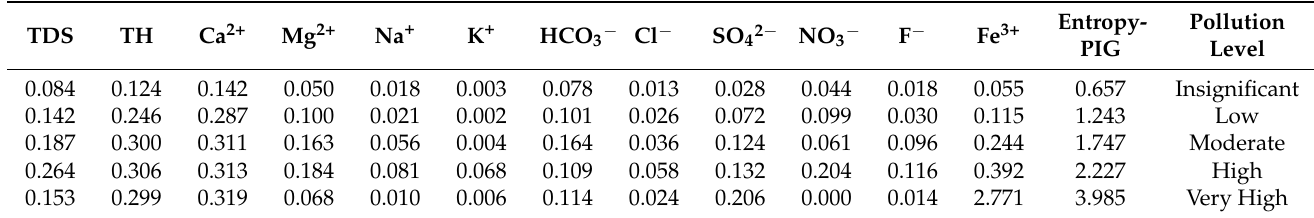
Table 9. Average values of the overall water quality of each chosen parameter in five pollution-level zones obtained using the Entropy-PIG